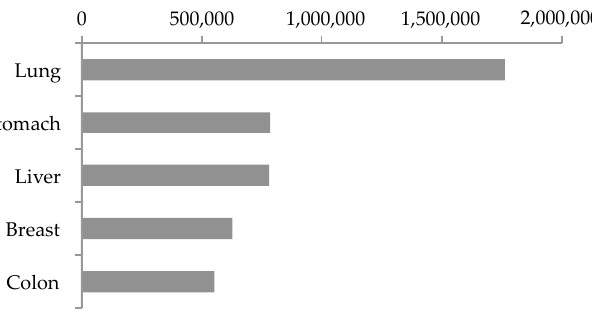
Figure 1. Estimated number of worldwide deaths of the top five cancers in 2018